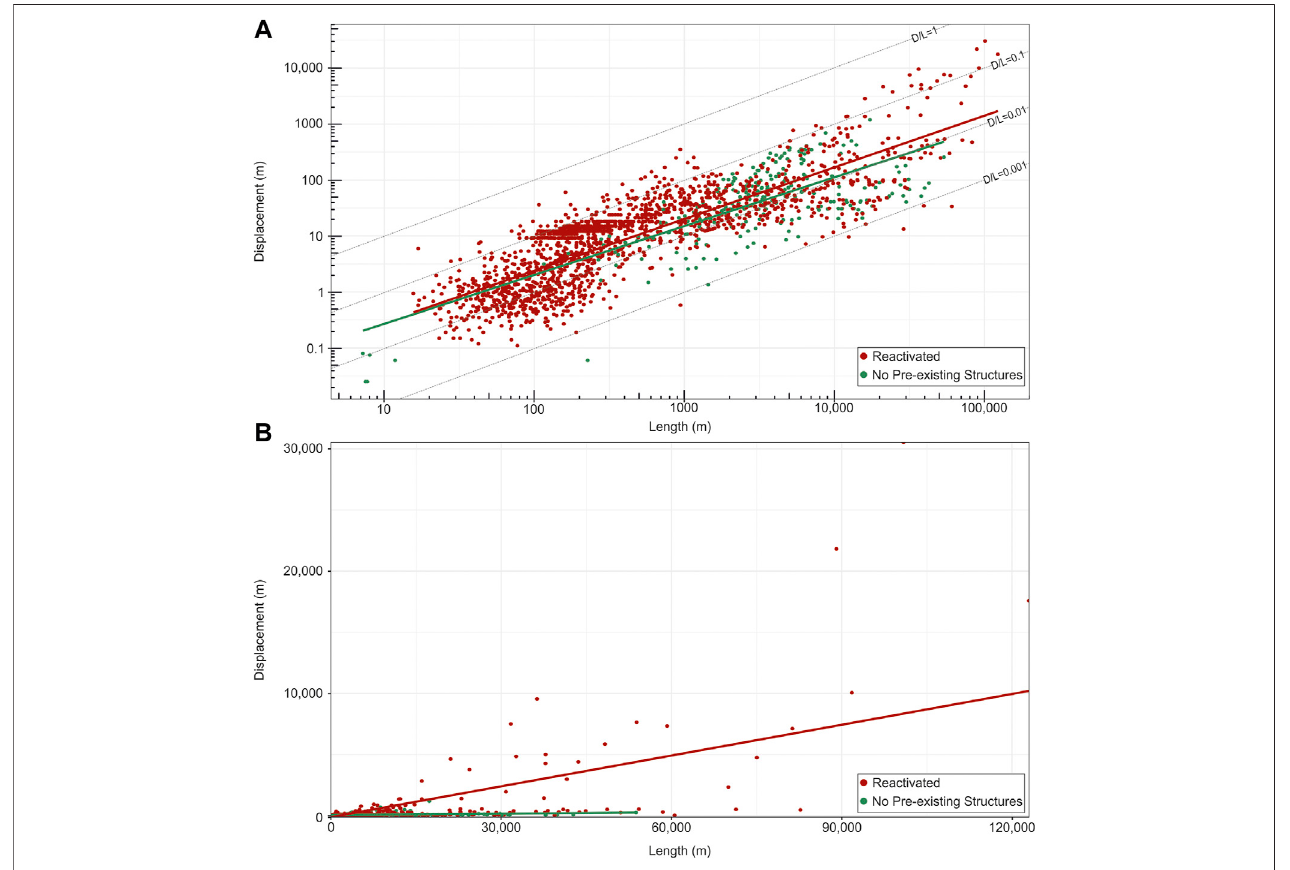
FIGURE 6 | Plots showing fault length vs. displacement for reactivated and non-reactivated normal faults in our database. (A) Data in log-log space. (B) Data in linear space.